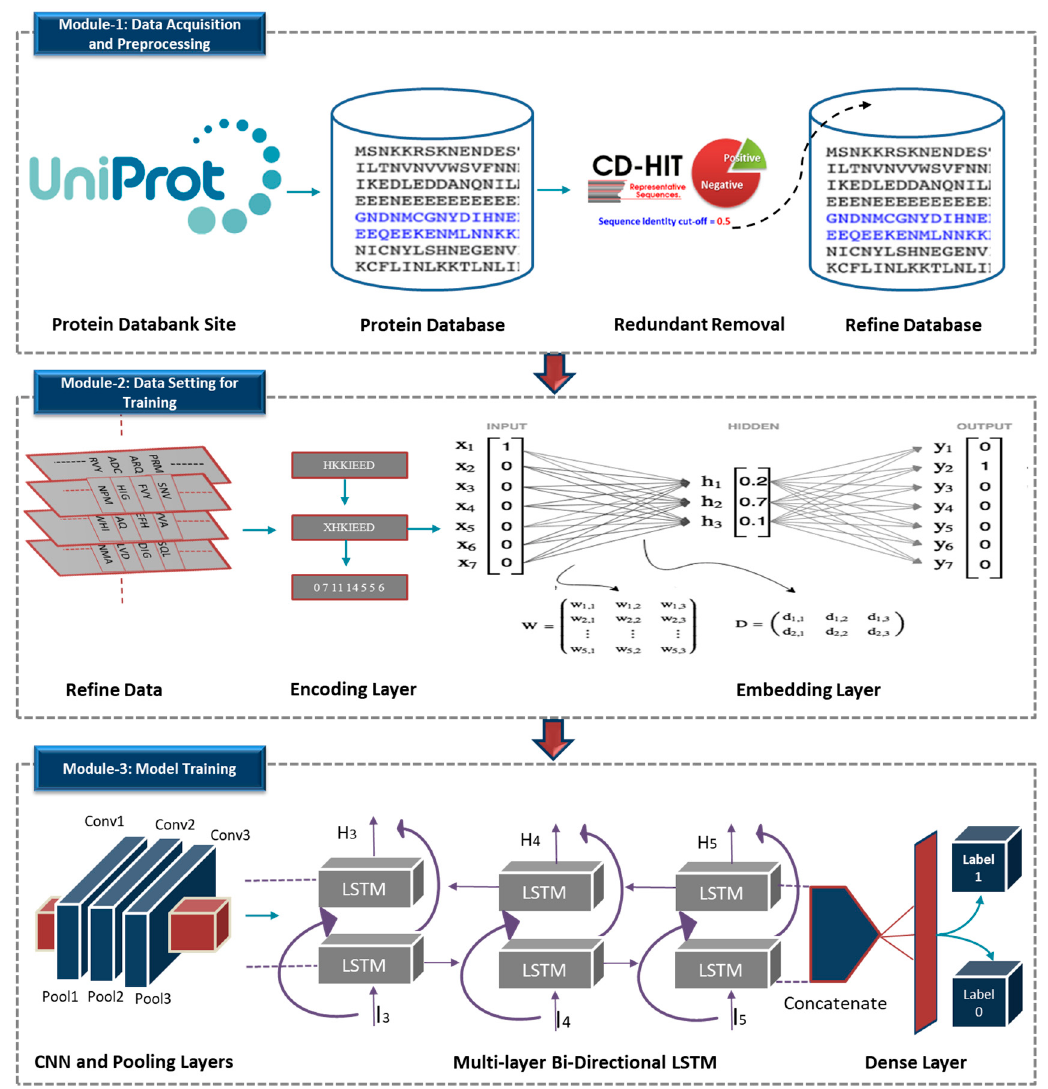
Figure 2. The proposed framework comprises of three modules. Module 1 describes the phenomena of sequence acquisition in which collection and preprocessing is channeled to eliminate redundancy.